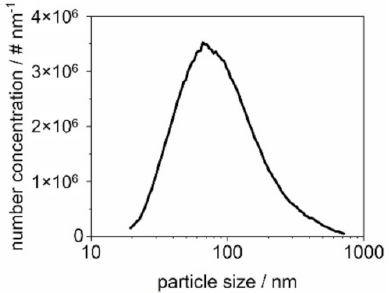
Figure 5. Particle size distribution of the K 2 SO 4 of the raw gas side used for fractional separation efficiency